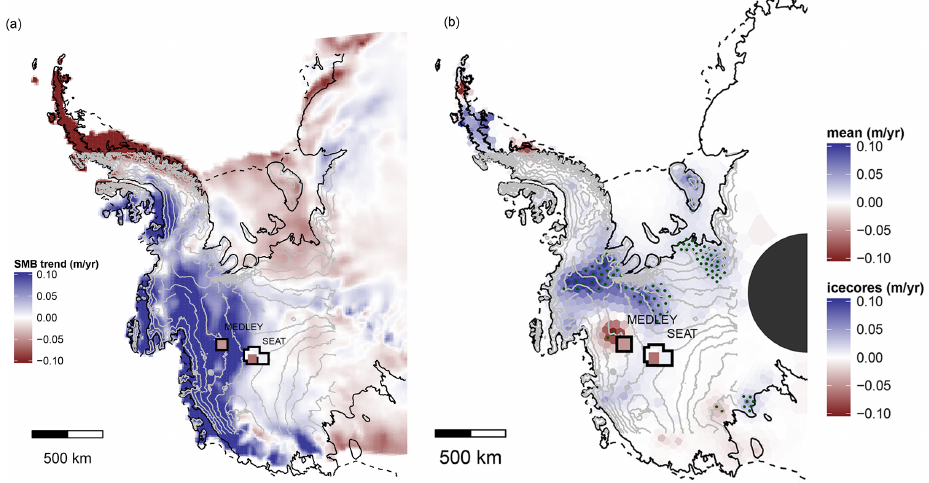
Figure 4. (a) The SMB trend for 2003–2009 as obtained from RACMO. Contour lines (shown from − 1000 to 1000km Northing) are elevations from BEDMAP surface (Fretwell et al., 2013). Mean ice core accumulation rates from Medley et al. (2013) (denoted MEDLEY) and ice core accumulation rates from Burgener et al. (2013) (denoted SEAT). Rectangle shows area in close-up (Fig. 5). (b) SMB rates for 2003–2009 in myr − 1 and locations of the ice cores from Burgener et al. (2013) and Medley et al. (2013). Contour lines are elevations from the BEDMAP surface (Fretwell et al., 2013). Stippled points denote areas in which the mean signal is larger than the marginal standard deviation.